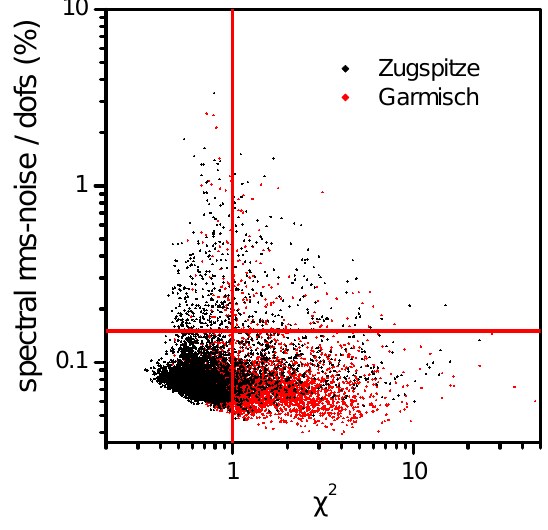
Fig. 4. Quality selection criteria and thresholds for goodness of fit ( χ 2 ) and spectral quality (rms-noise) relative to information content (dofs). Data points are for 5 years of